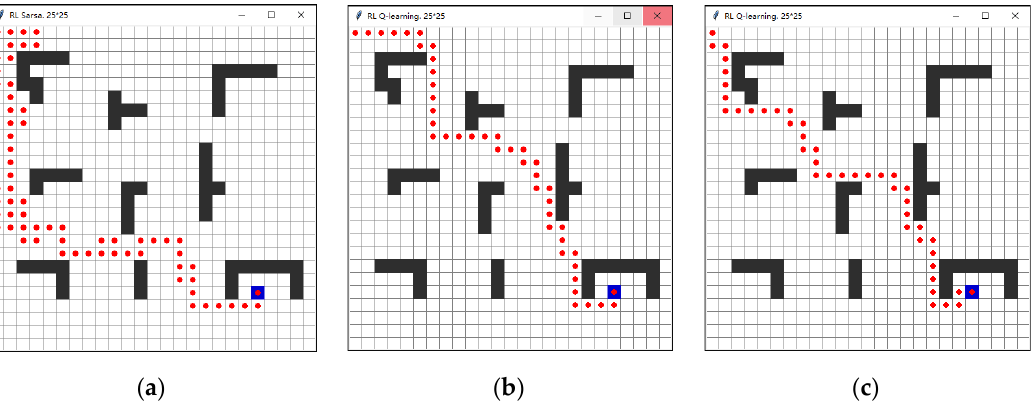
Figure 5. Simulation results of path planning under a 25 × 25 environment. ( a ) Path planning of the SARSA algorithm; ( b ) Path planning of the Q-learning algorithm; ( c ) Path planning of the proposed Q-learning optimization algorithm.